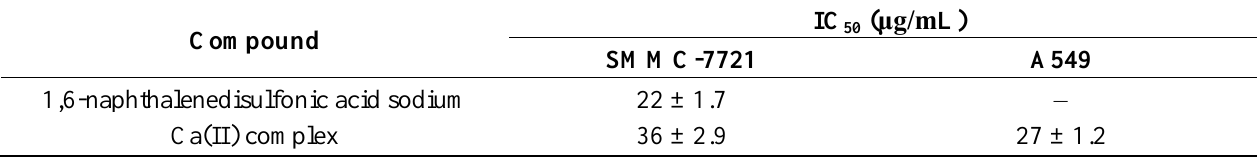
Table 2. Antitumor activities of Ca(II) coordination polymer and 1,6-naphthalenedisulfonic acid disodium